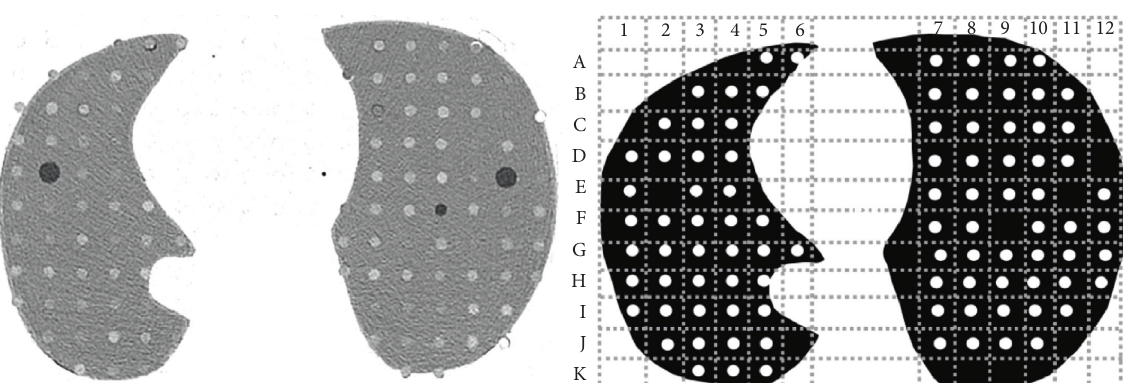
Figure 1: Example of the selected CT slice the radiologists analyzed and the printed diagram in which they registered the nodules they detected. Peripheral nodules such as A3, A4, and B2 were excluded from analysis because of their interface with the chest wall. Positions E2, E11, and F9 had no simulated nodules and served as reference to count columns and